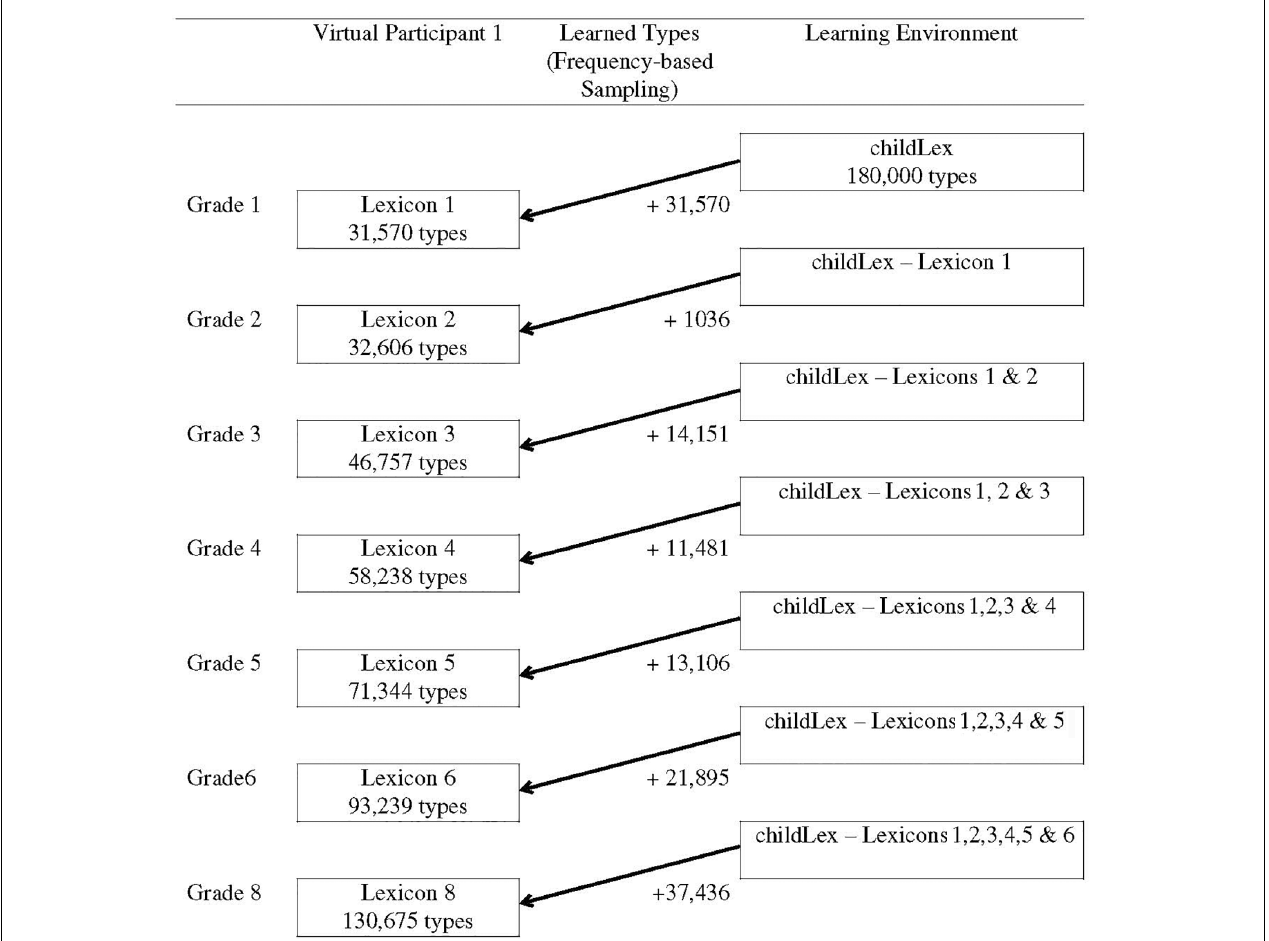
FIGURE 1 | Schematic Illustration of the sampling procedure for one virtual